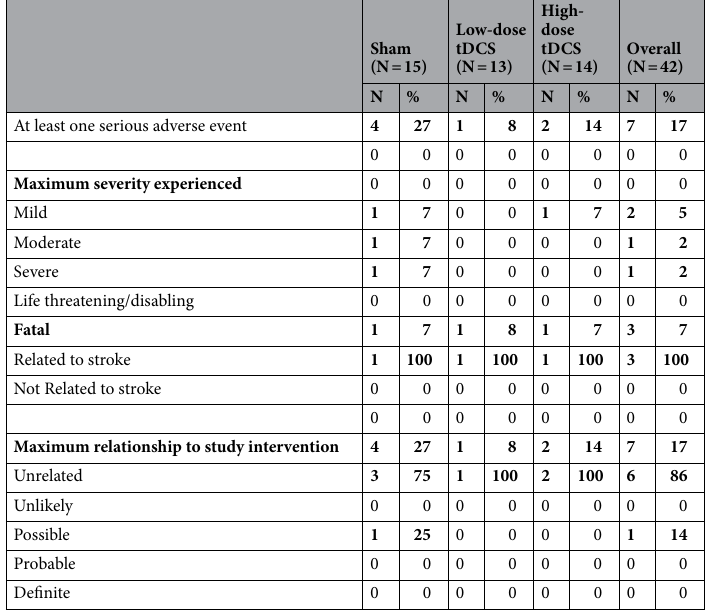
Table 2. Serious adverse events summary.